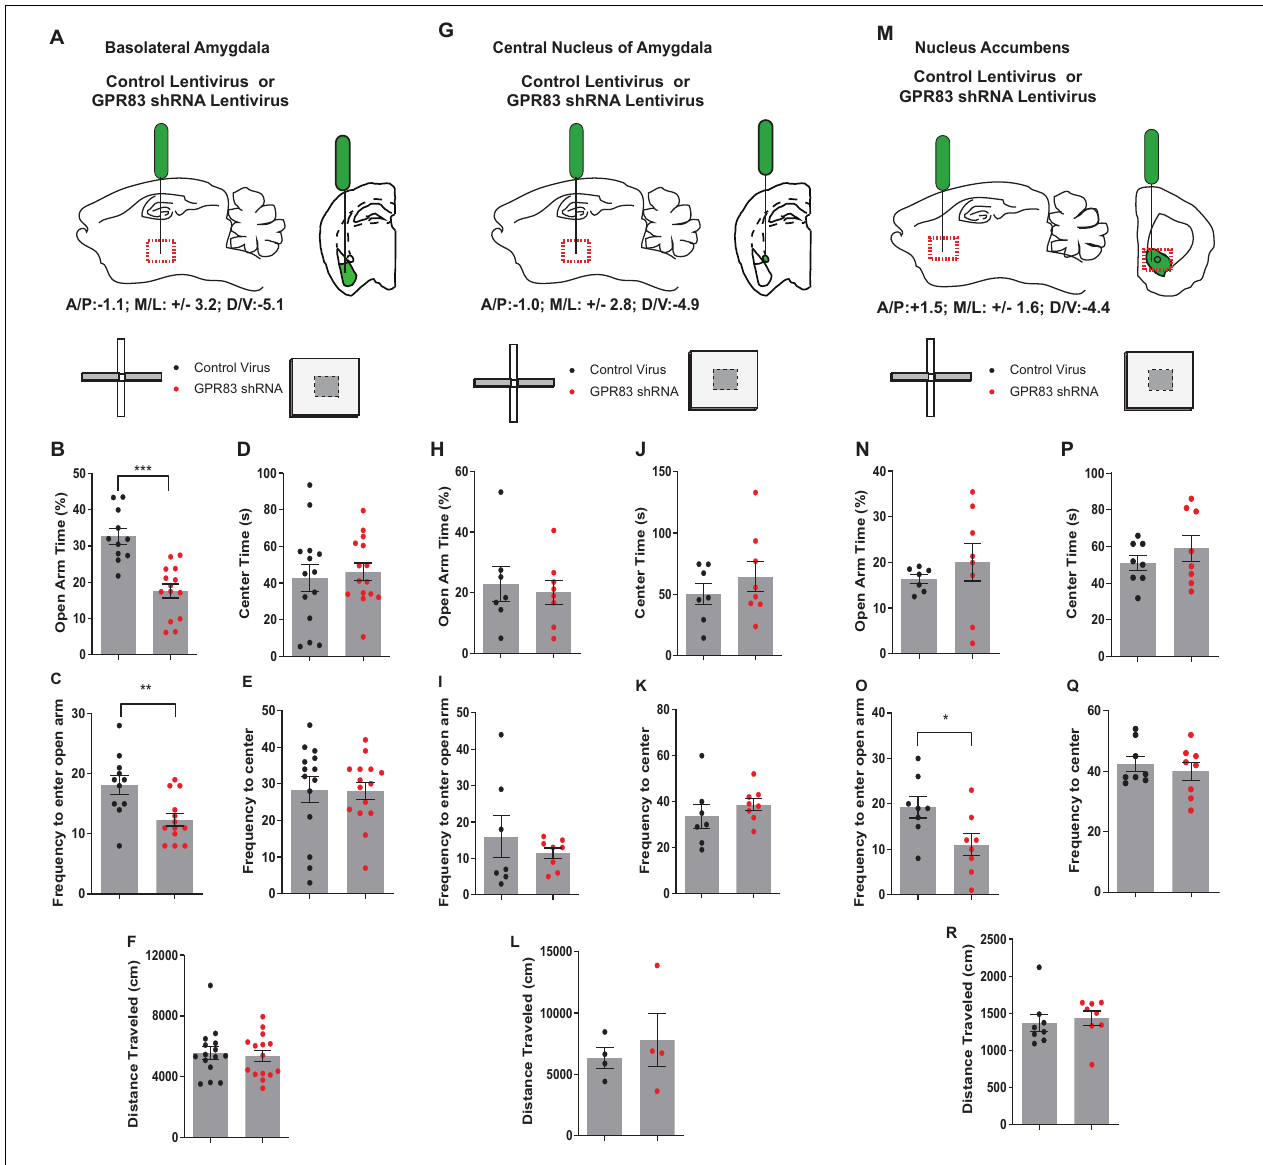
FIGURE 5 | GPR83 knockdown in the BLA, but not the CeA or NAc increases anxiety-related behaviors in female mice. Schematic of injection of control or GPR83 shRNA lentivirus into the (A) BLA, (G) CeA, or (M) nucleus accumbens. Effect of brain region specific GPR83 knockdown in mice on open arm time in the elevated plus maze (B,H,N) and on the frequency to enter the open arm (C,I,O) . Effect of brain region specific GPR83 knockdown in mice on the center time in the open field assay (D,J,P) , on frequency to enter the center (E,K,Q) and on the distance traveled (F,L,R) . Data are represented as mean ± SEM and analyzed using unpaired t -test, % = open arm time/(open arm + closed arm time), * p < 0.05, ** p < 0.01, *** p < 0.001, BLA, CV n = 11, GPR83 shRNA n = 14; CeA, CV n = 7, GPR83 shRNA n = 8; NAc, CV n = 8, GPR84 shRNA n = 8.